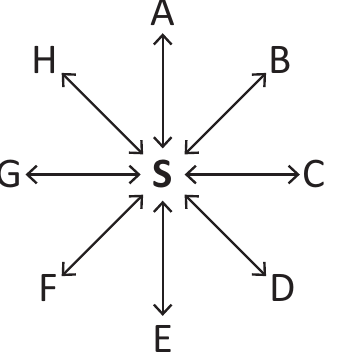
Figure 2. Hub-and-spoke network development (Starkey, 2006).